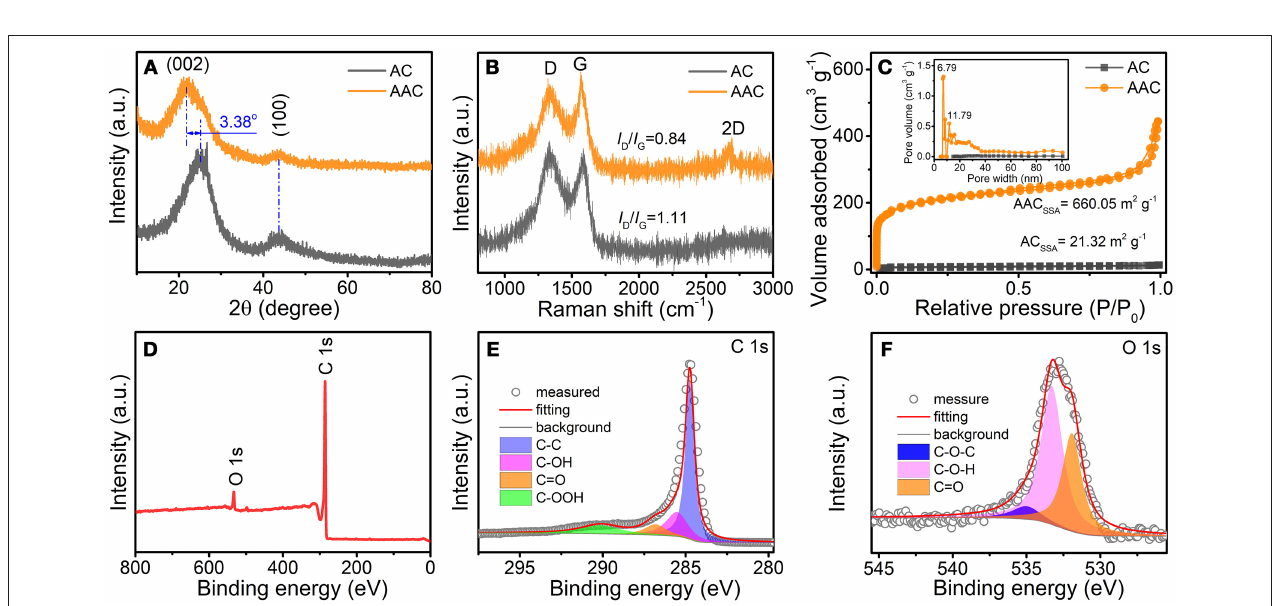
FIGURE 3 | (A) XRD patterns, (B) Raman spectra, and (C) N 2 sorption isotherms (inner figure is pore size distributions) of AAC and AC; (D) XPS survey scan spectrum of AAC; (E,F) high resolution XPS spectra of (E) C 1s and (F) O 1s.